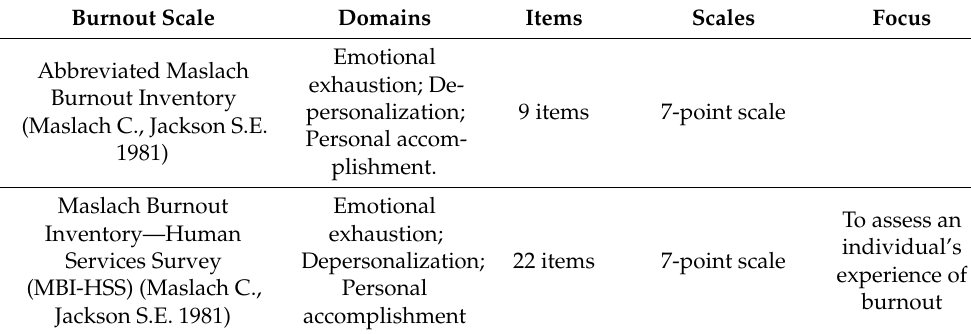
Table 2. Burnout